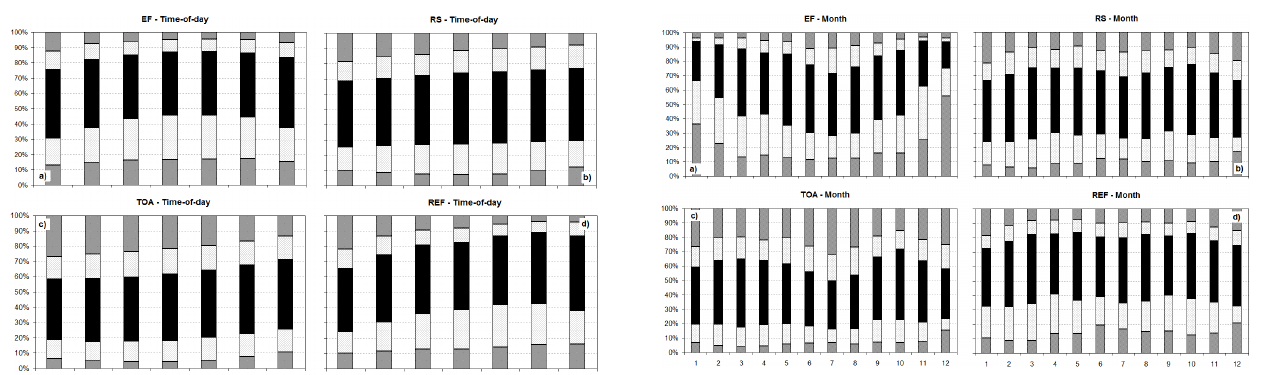
Figure 3. Variability of the accuracy of upscaling methods as a function of satellite acquisition time-of-day. The black central bar represents the frequency of data between ET max and ET min , the light-gray bars represent the “moderate” errors, while dark gray bars represent “major” errors. Frequencies of underestimation ( < ET min ) and overestimation ( > ET max ) are indicated by bars be- low and above the black bar, respectively. See the text for the defi- nition of “moderate” and “major” errors.